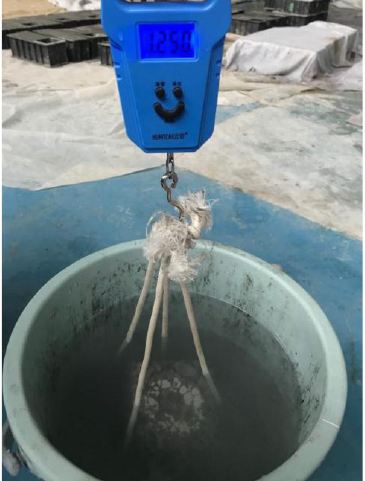
Figure 10. The testing of porosity.